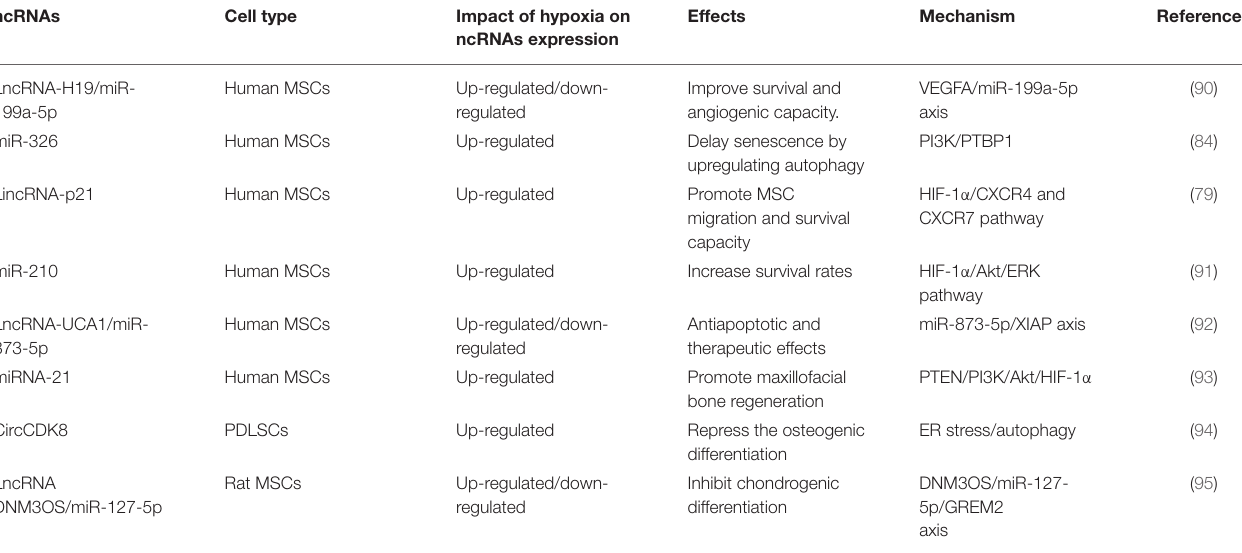
TABLE 2 | Non-coding RNAs involved in regulating the fate and regeneration of MSCs under hypoxia.